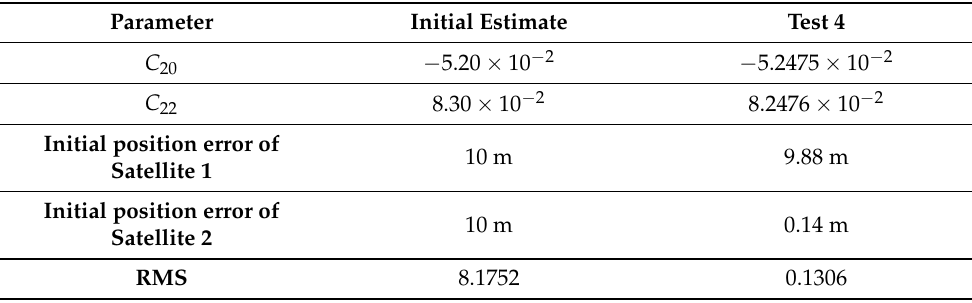
Figure 11. Residual in the observation data ( left ) and norm of the position error of the determined orbit from the true one ( right ) (test 8). Table 8. Recovery result of test